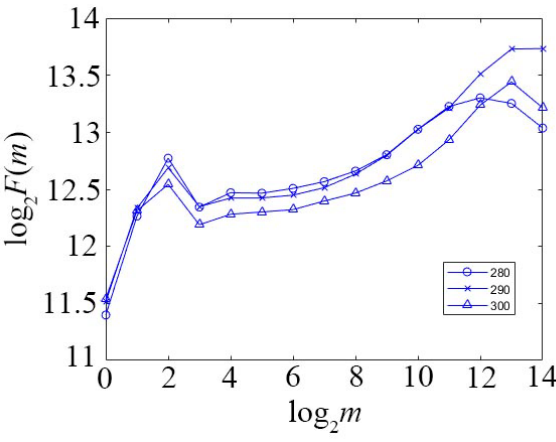
Figure 2. log 2 F ( m )~log 2 m curve for various range bin.